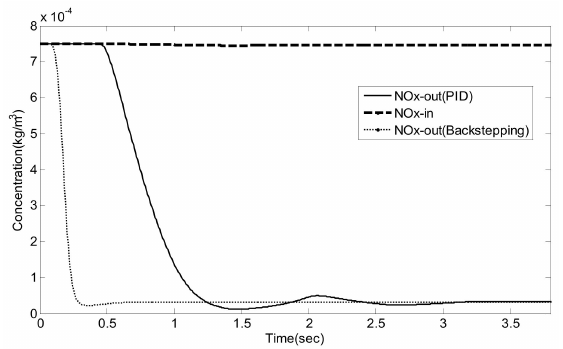
Figure 17. NO / NO 2 = 2 / 1, NOx conversion e ffi ciency.